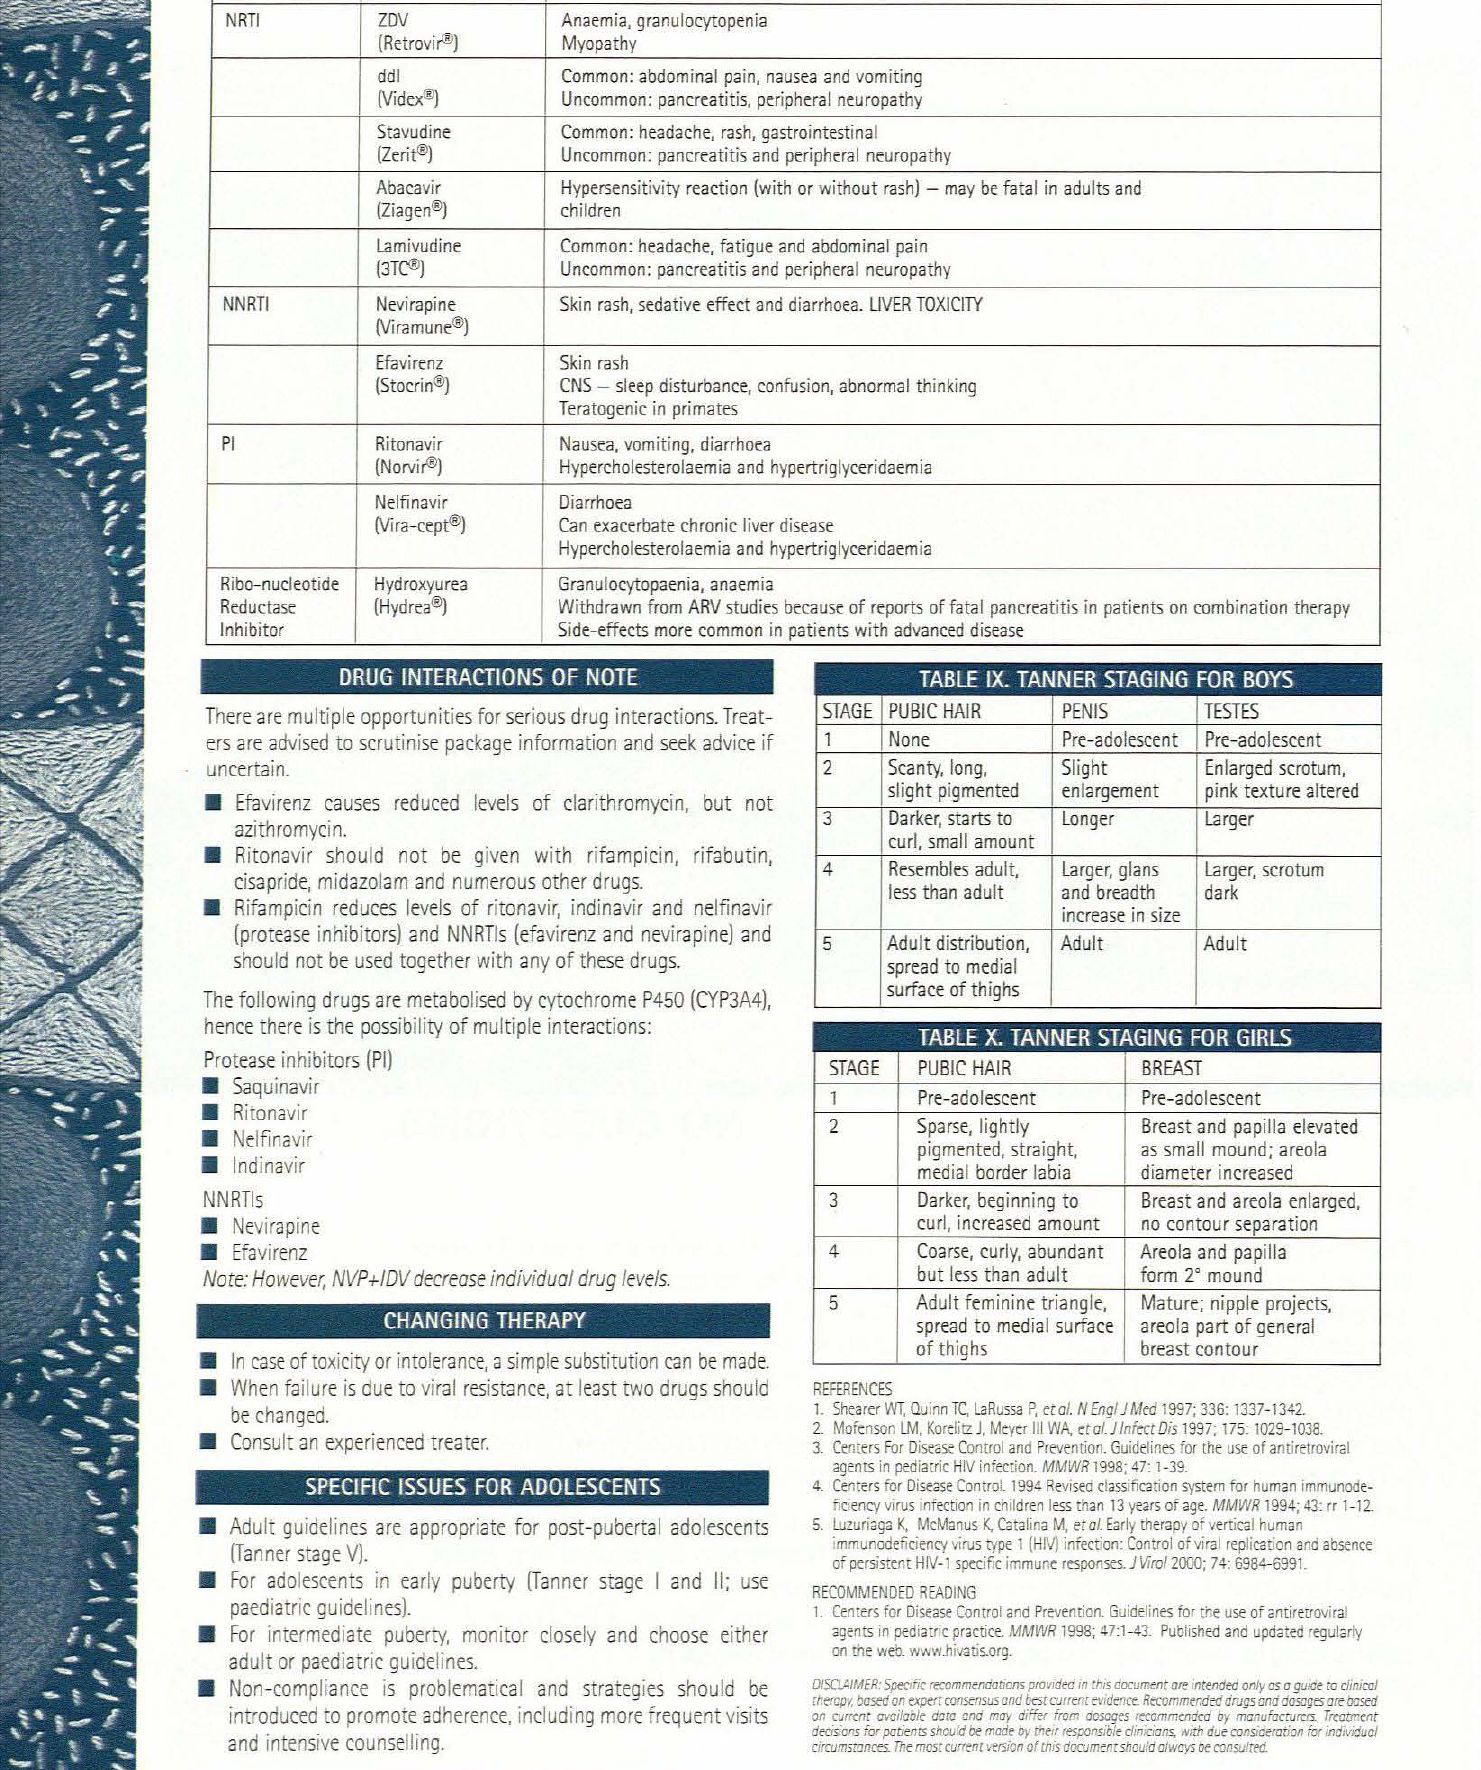
TABLE IX. TANNER STAGING FOR BOYS